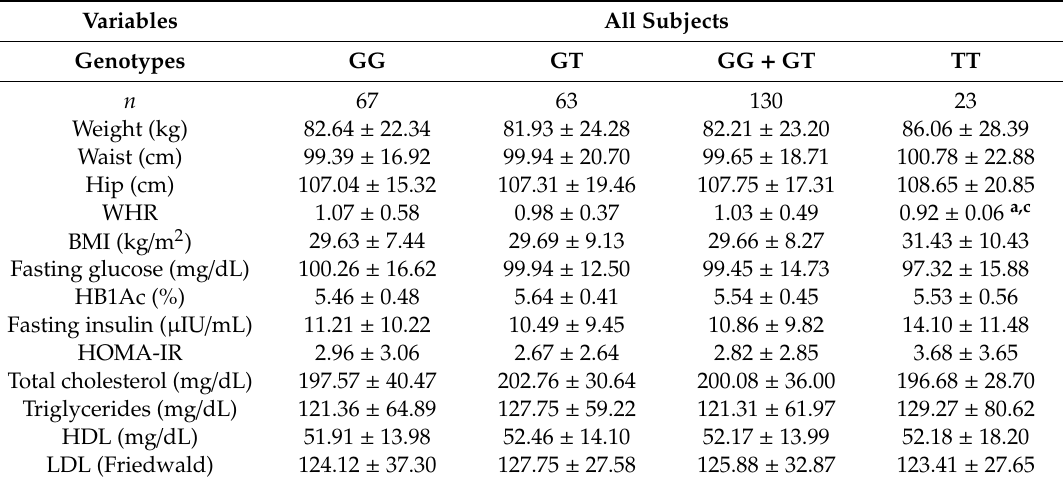
Table 3. General data of all subjects according to the APOA2 rs3813627 genotypes.